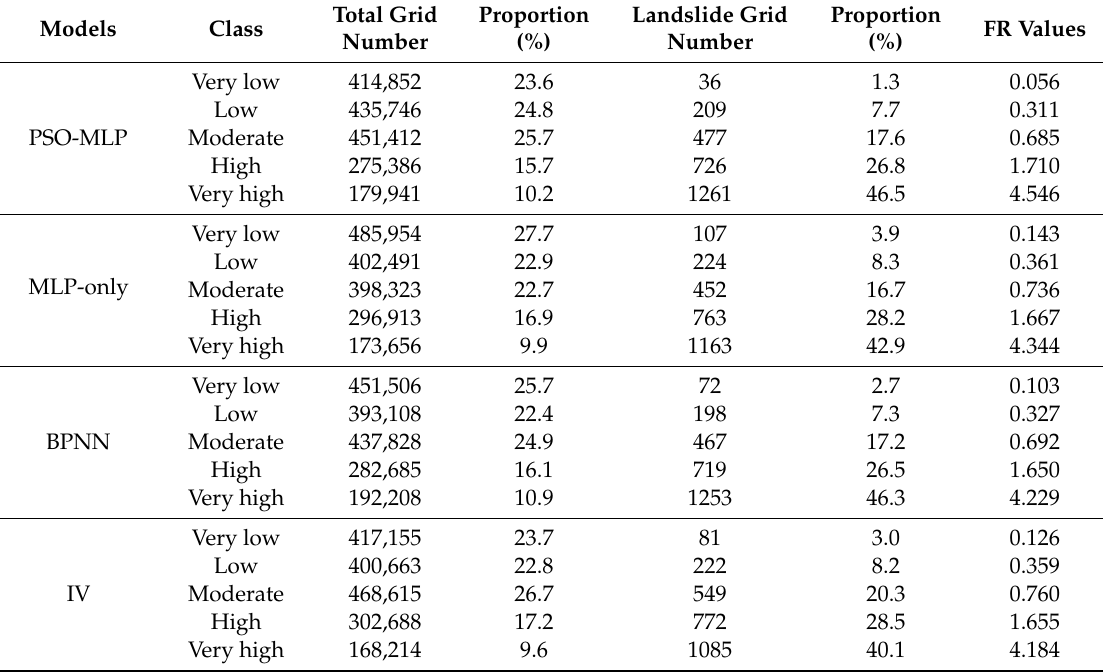
Table 2. FR values of landslide susceptibility levels classified by the four